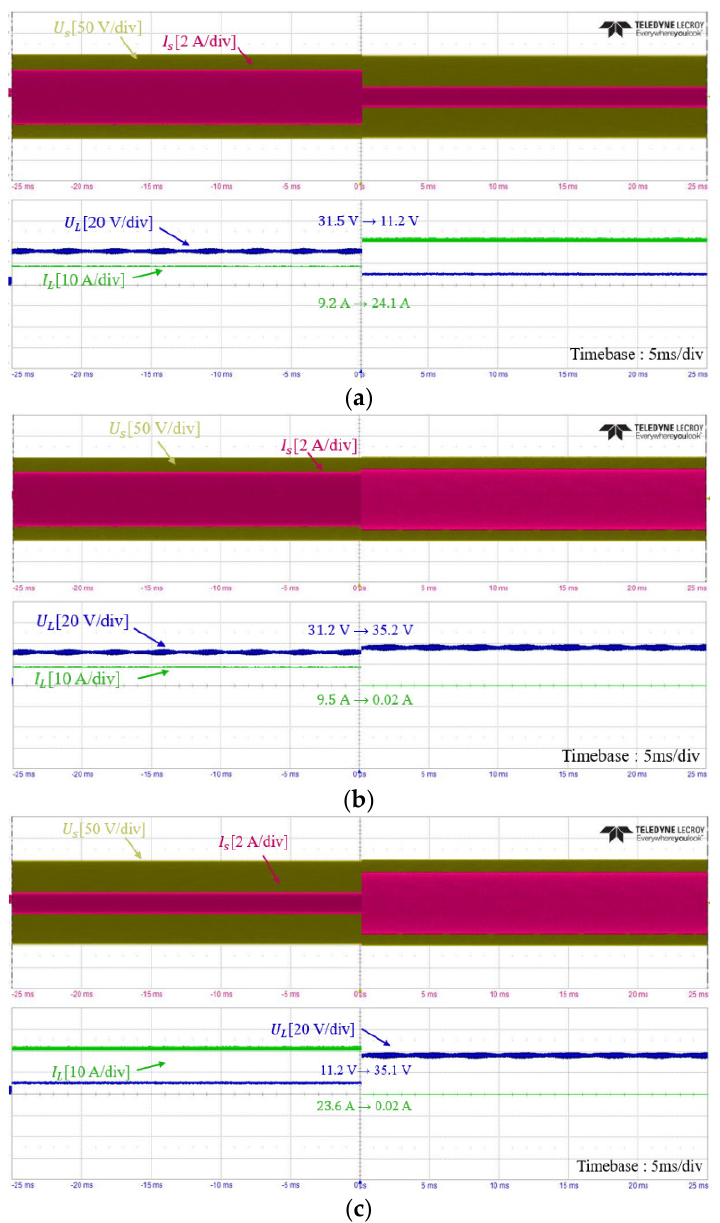
Figure 10. Input/output current and voltage waveforms for the proposed topology are: ( a ) from charging to short − circuit load; ( b ) from charging to open − circuit load; and ( c ) from short − circuit load to open − circuit load. Table 4. Result of prototype (Charging and fault) experiments.